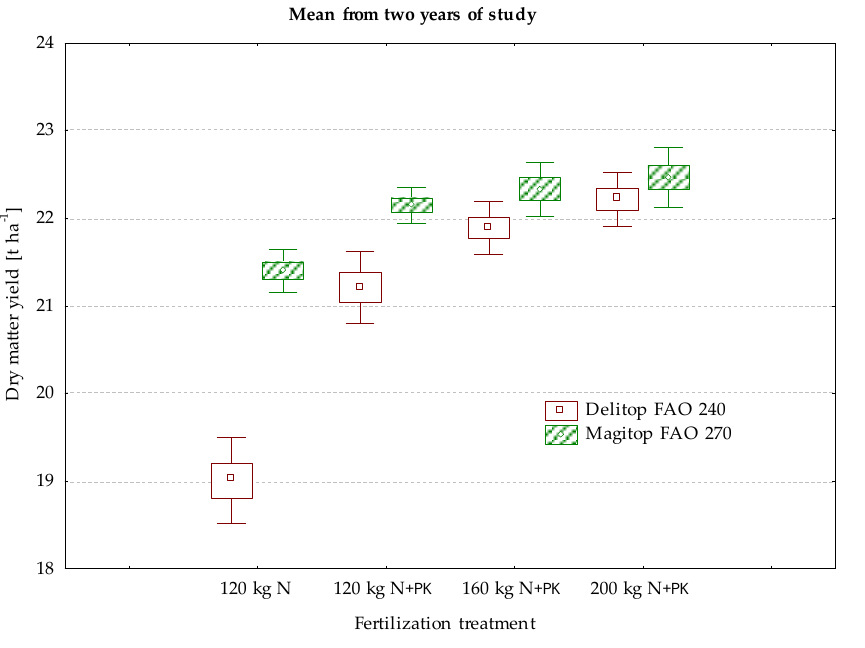
Figure 6. Boxplot of the DMY of two maize varieties during two study years. Table 4. DMY of maize biomass depending on the fertilization variant and variety (t · ha − 1 ). Fertilization Treatment Years of Study